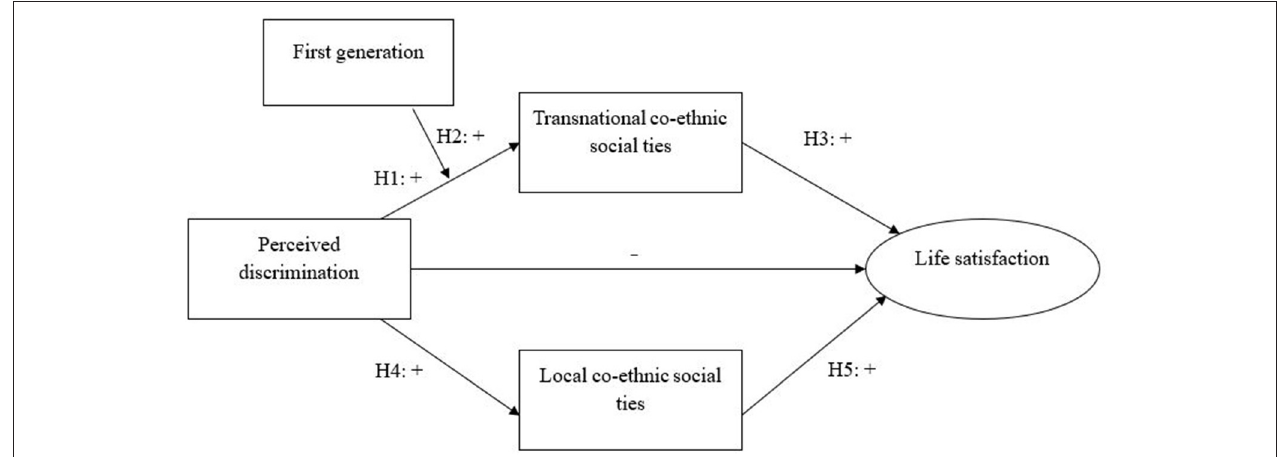
FIGURE 1 | Theoretical model. Control variables: Age, gender, employment, Dutch language skills, education, financial difficulties, share of co-ethnic